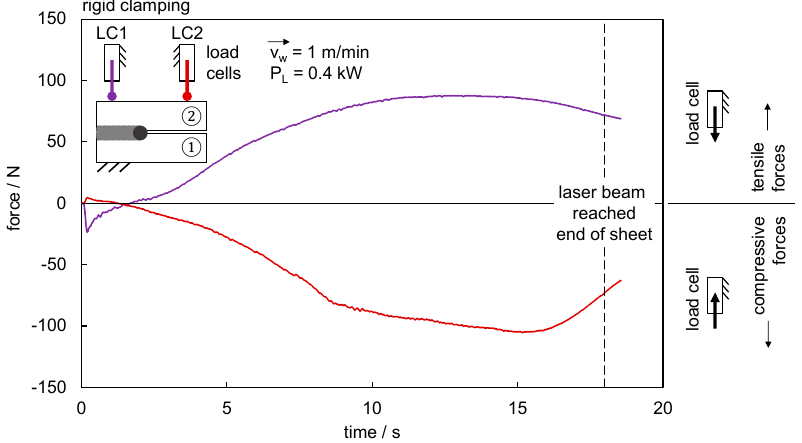
Figure 9. Force measurement of a rigid clamping for an uncontrolled process (v w = 1 m/min, P L = 0.4 kW).